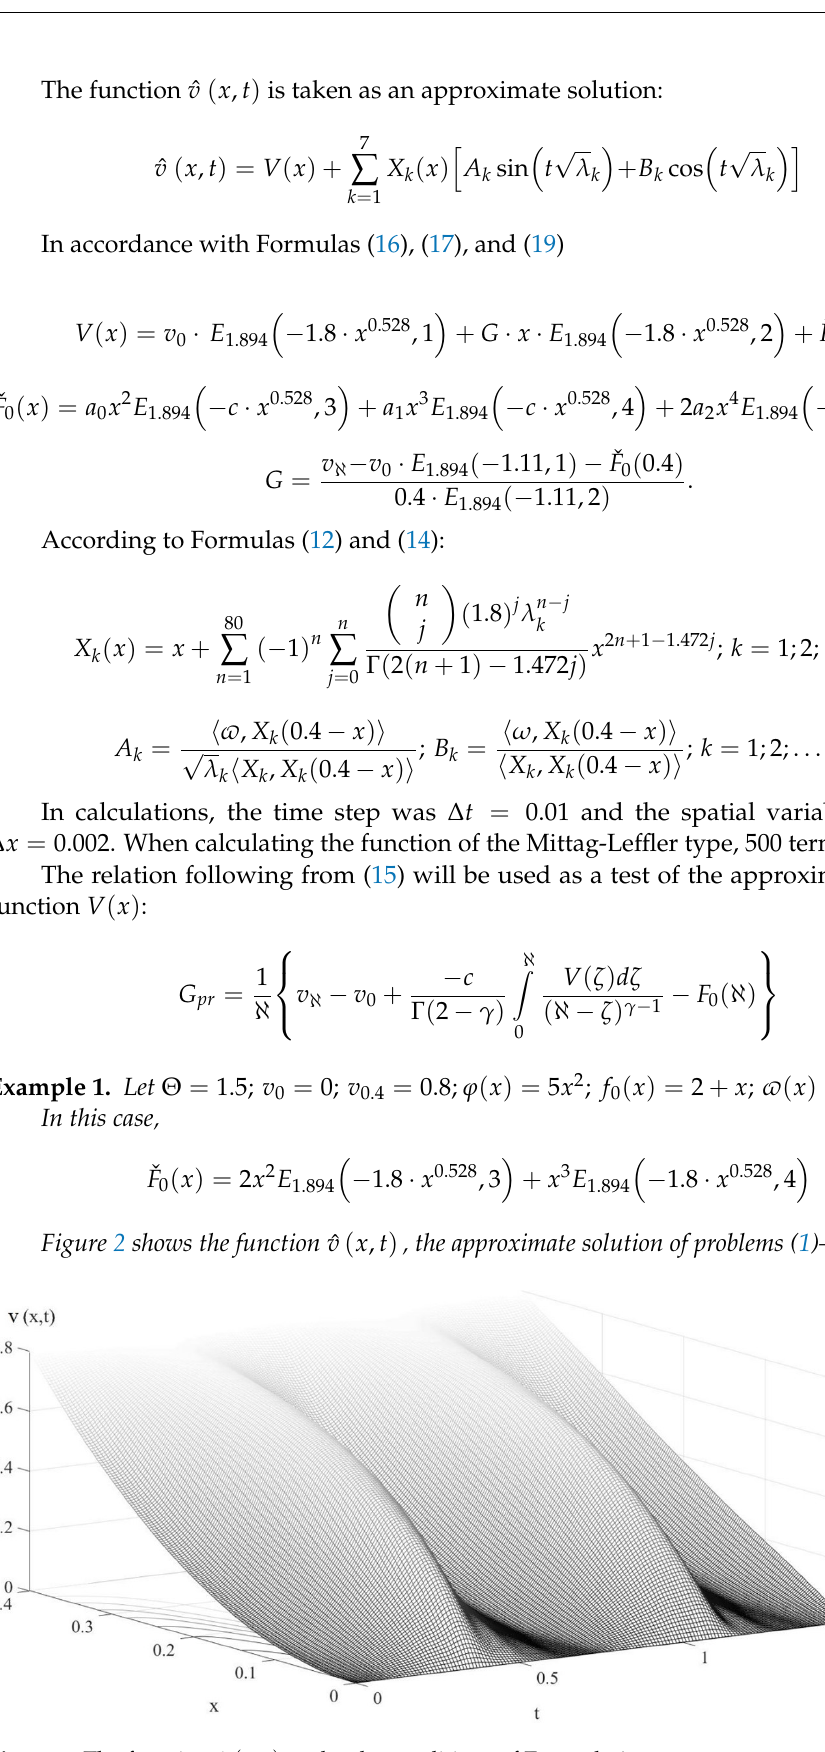
Figure 2. The function ˆ v ( x , t ) under the conditions of Example